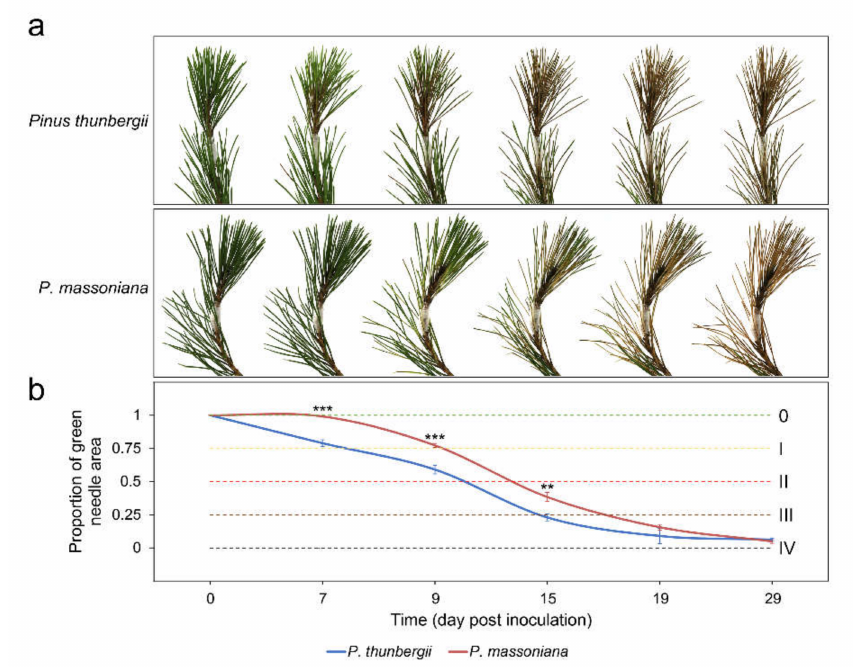
Figure 1. Changes in pines inoculated with pine wood nematodes. ( a ) Symptoms of pines after inoculation; ( b ) change in the color of the pine needles. 0: healthy; I: a quarter of the needles were chlorotic; II: half of the needles were chlorotic, turned brown and died, and the branch tip was deformed and bent; III: three-quarters of the needles were chlorotic, turned brown and died, and the branch tip sagged; IV: all of the needles were chlorotic, turned brown and died, and the whole plant wilted. Error bars indicate the standard deviation (*** p value < 0.001, ** p value < 0.01, P. massoniana test P. thunbergii ).